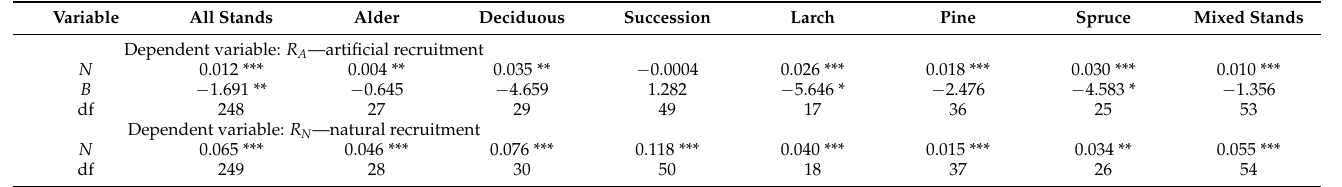
Table 3. Estimated regression parameters of the recruitment model with artificial regeneration (Equation (16)) and the recruitment model with natural regeneration (Equation (15)).